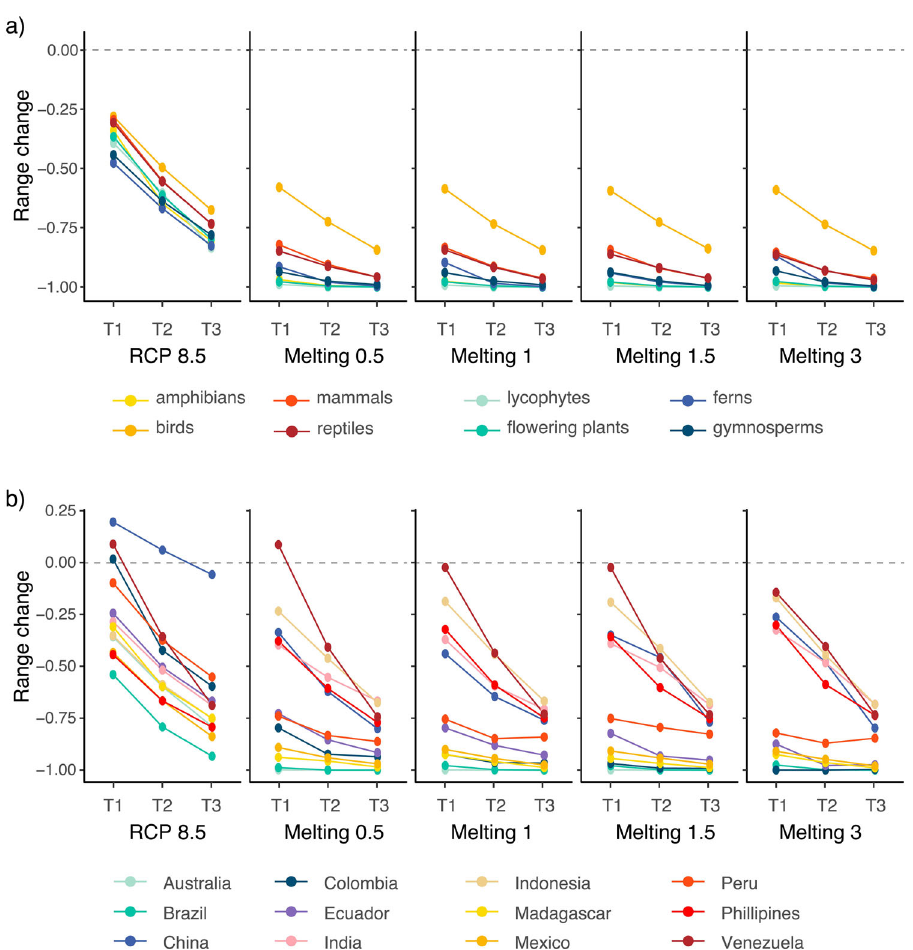
Fig. 2 Changes in the size of the distribution range of species across taxonomic groups and countries under fi ve scenarios of climate change at three different time horizons. a , b Estimated median range size change for the eight a taxonomic groups and b countries across scenarios and time horizons. Species range sizes were standardized relative to the present-day species range size and then summarized across groups: negative values indicate range reductions (1 means complete loss), and positive values indicate range expansions. T1: 2030; T2: 2050; T3: